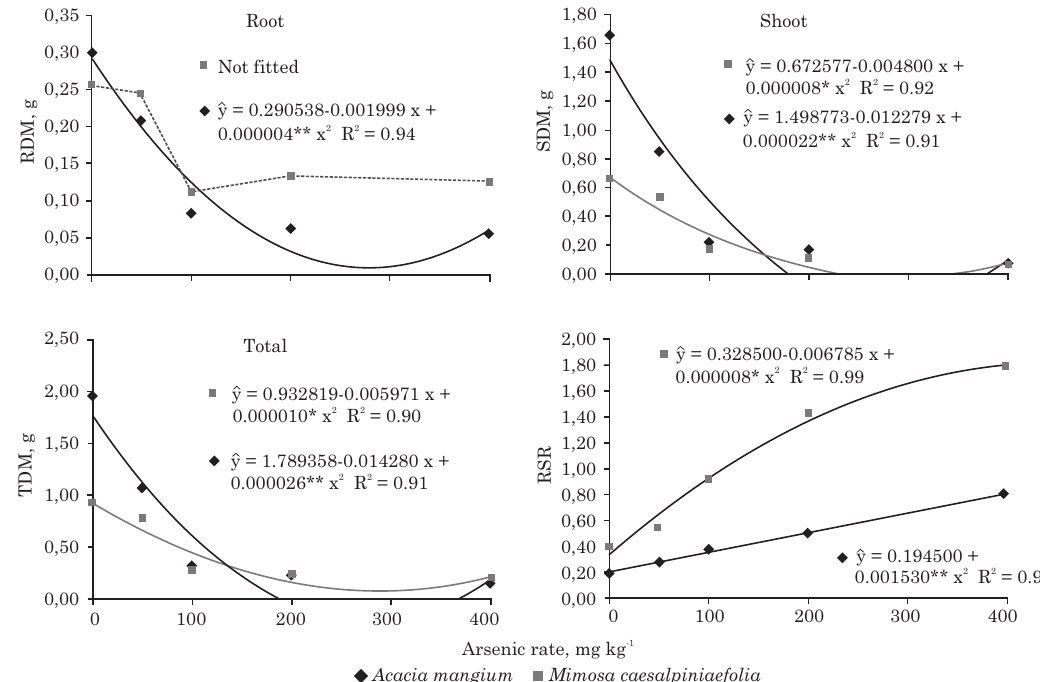
Figure 1. Root dry matter (RDM), shoot dry matter (SDM), total dry matter (TDM) and root/shoot ratio (RSR) of Acacia mangium ( uuuuu ) and Mimosa caesalpiniaefolia ( nnnnn ) seedlings as a function of the arsenic rate added to the substrate. * and **: significant at the 5 and 1 %,